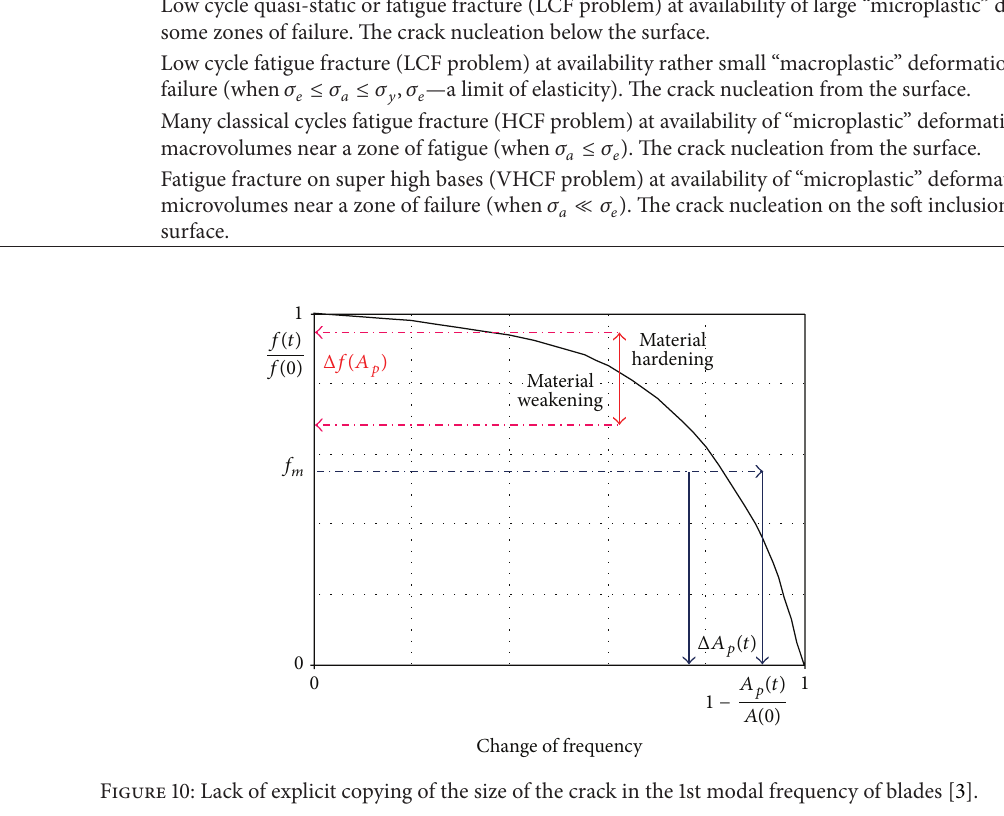
Table 2: The fatigue of metal compressor blades at numbers of load cycles in the range 10 0 –10 12 [69]. Number of cycles Description 10 0 –10 3